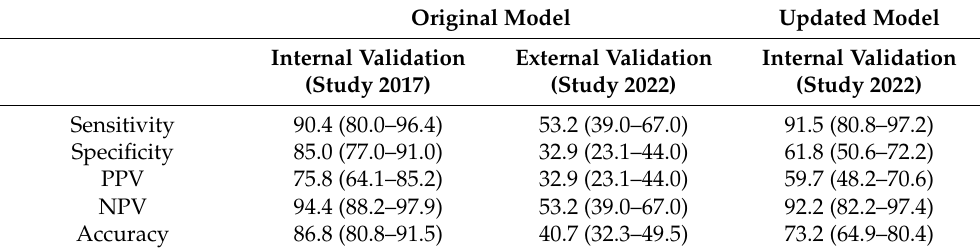
Table 3. Performance characteristics of the original prediction model, determined by internal and external validation, and of the updated prediction model, determined by internal